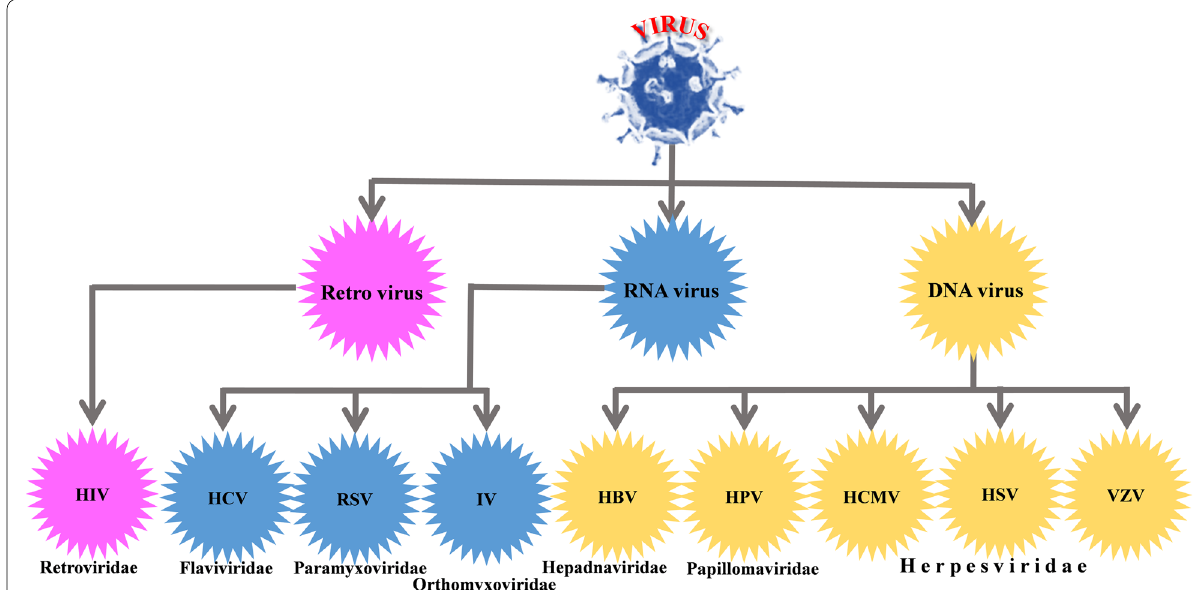
Fig. 1 Classification of infective human viral diseases and their characteristic sub division and family are a Retrovirus (Human Immunodeficiency Virus (HIV), Family: Retroviridae); b RNA virus (Hepatitis C virus (HCV), Family: Flaviviridae), Respiratory Synctial virus (RSV), Family: Paramyxoviridae), Influenza virus (IV), Family: Orthomyxoviridae); c DNA virus (Hepatitis B virus (HBV), Family: Hepadnaviridae), Human Papilloma virus (HPV), Family: Papillomaviridae), (Human Cytomegalo virus (HCMV), Herpes simplex virus (HSV), Varicella-Zoster virus (VZV)-Family: